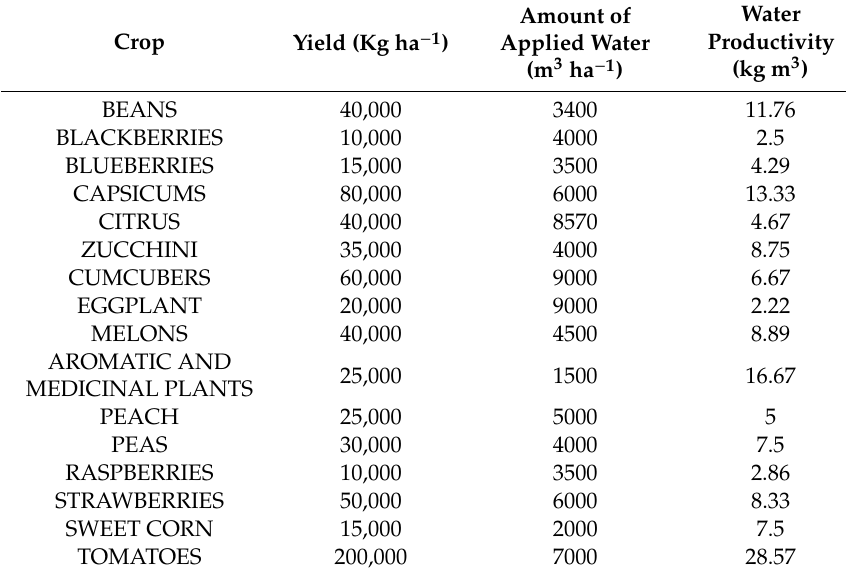
Table 8. Actual water productivity of different crops in Chtouka Ait Baha.